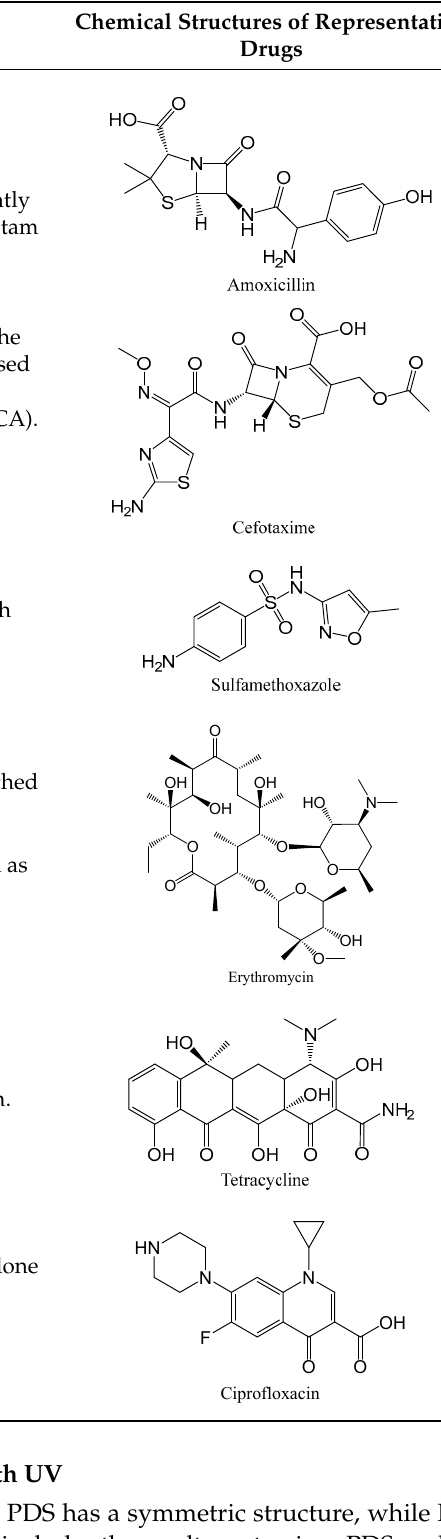
Table 2. Common antibiotics in water and their chemical structures.